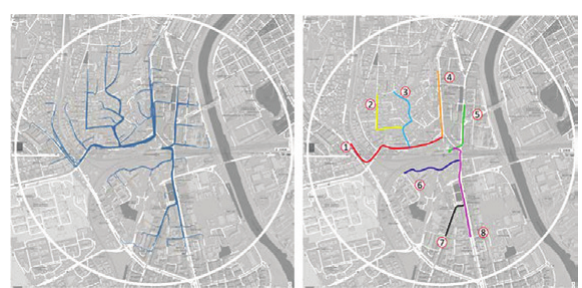
Figure 1. Example of paths collected by survey and their aggregation for one of the selected